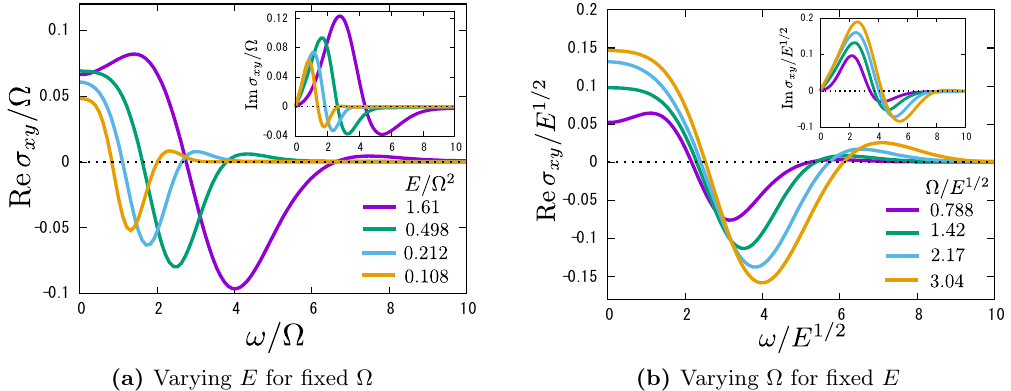
Figure 8. The optical Hall coe(cid:14)cients against the probe AC frequency ! . Curves in the left (right) (cid:12)gure correspond to several E ((cid:10)) for a (cid:12)xed (cid:10) ( E